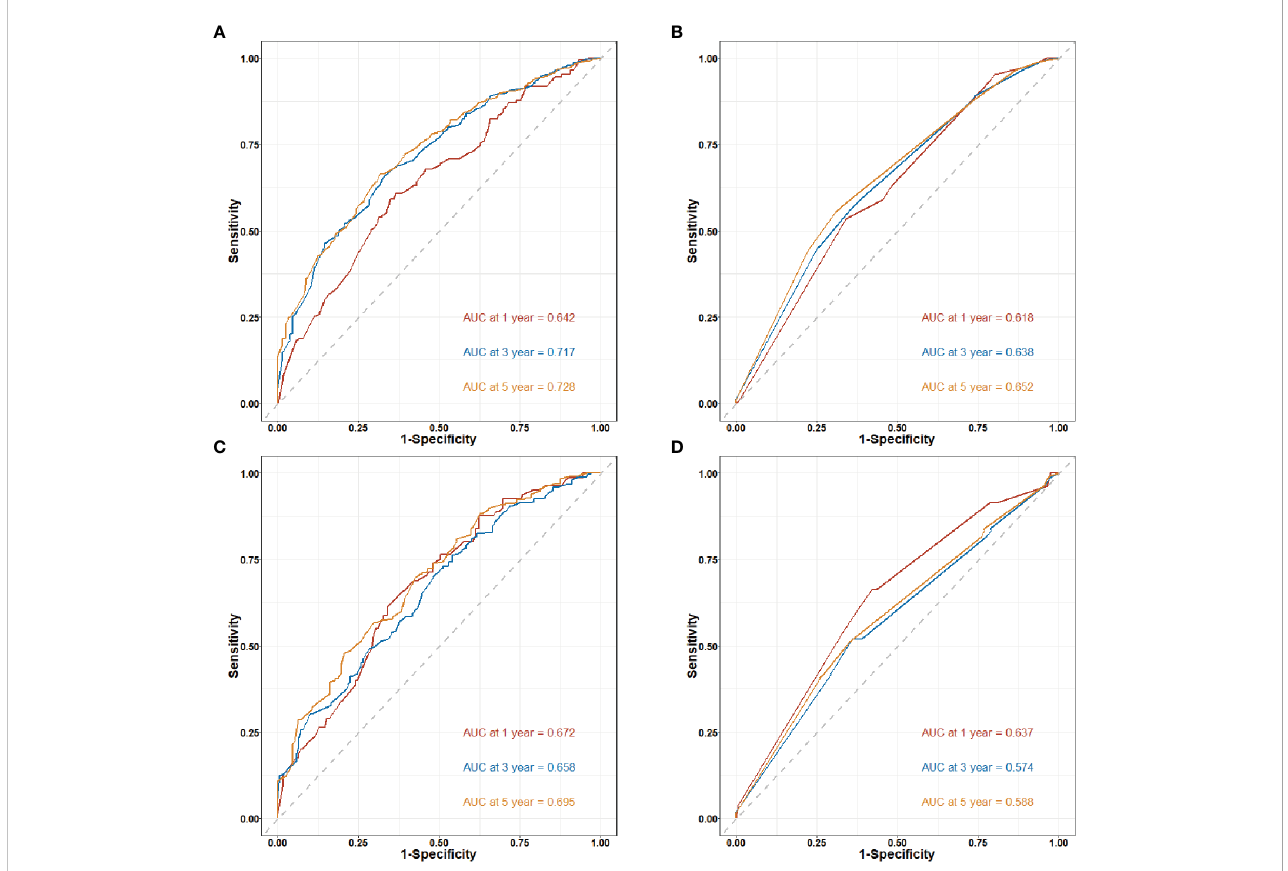
FIGURE 5 Time-dependent receiver operating characteristic (ROC) curves for nomogram in training and validation cohort. AUC. Area under the ROC curve; CI: con fi dence interval. (A) 1-year, 3-year and 5-year ROC curves of the clinical-pathological nomogram model in the training cohort. (B) 1-year, 3-year and 5-year ROC curves of the TNM stage nomogram model in the training cohort. (C) 1-year, 3-year and 5-year ROC curves of the clinical-pathological nomogram model in the validation cohort. (D) 1-year, 3-year and 5-year ROC curves of the TNM stage nomogram model in the validation